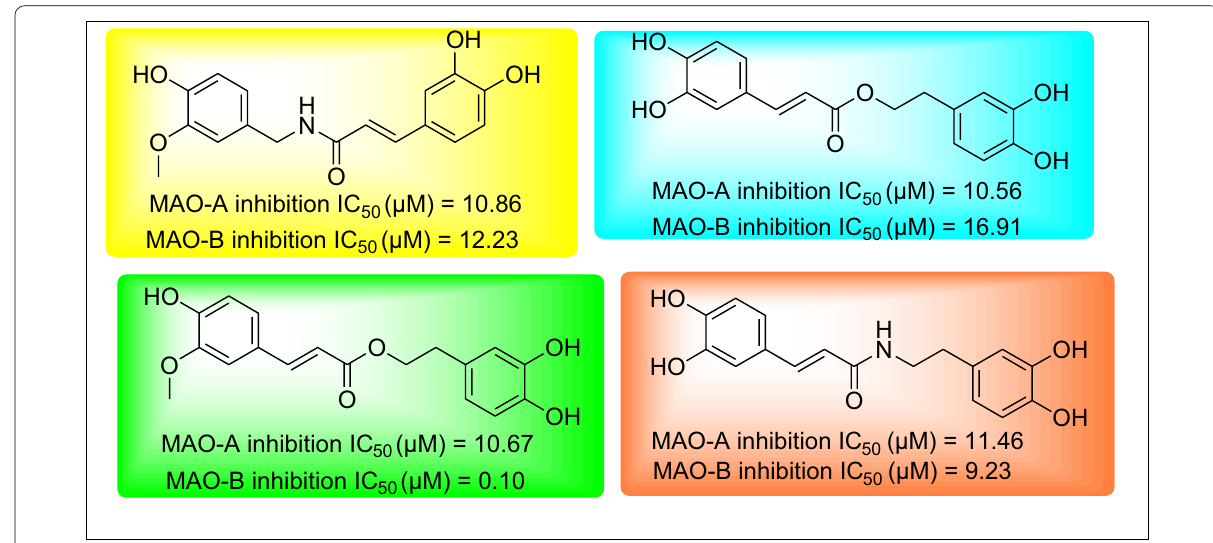
Fig. 1 MAO inhibitory profile of caffeic acid derivatives found in the recent